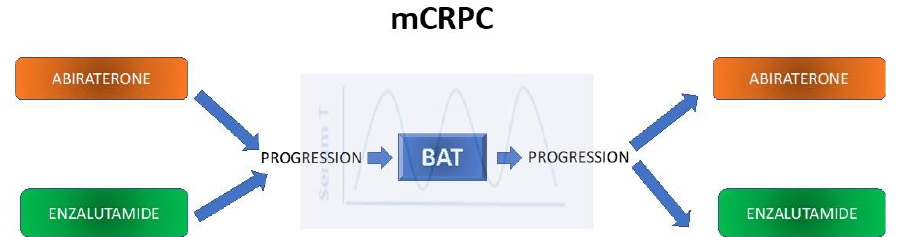
Figure 5. Scheme of the main studies showing BAT’s ability to resensitize to subsequent ARSi in